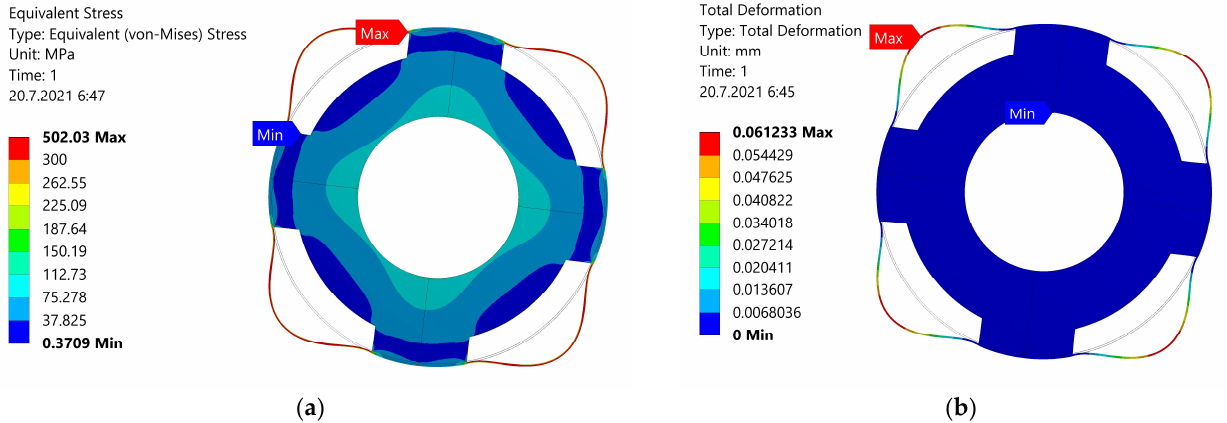
Figure 6. Mechanical analysis of the sleeve glued to the rotor: ( a ) Von Mises stress; ( b ) total deformation.